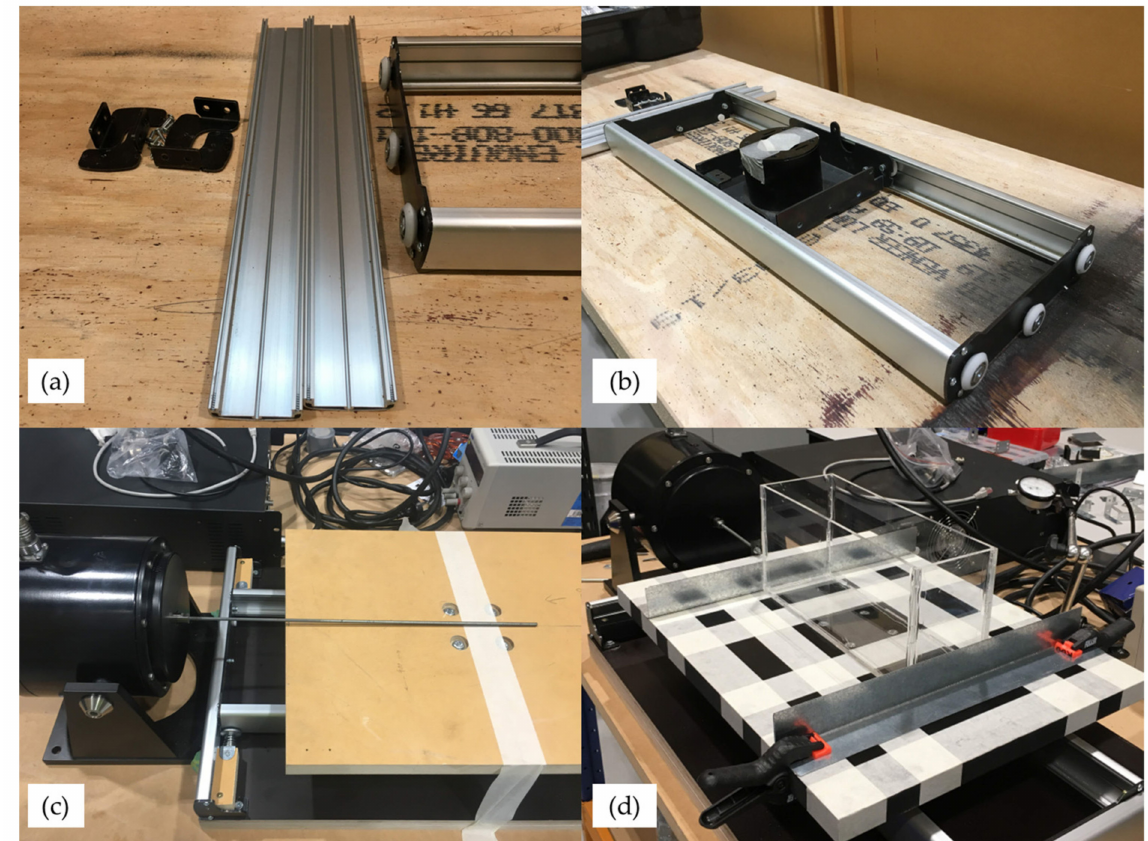
Figure 2. The sliding mechanism assembly for the shaking table. ( a ) Main parts of the sliding mechanism. ( b ) The sliding mechanism assembly. ( c ) The table and actuator assembly. ( d ) The adjustments and calibration of the shaking